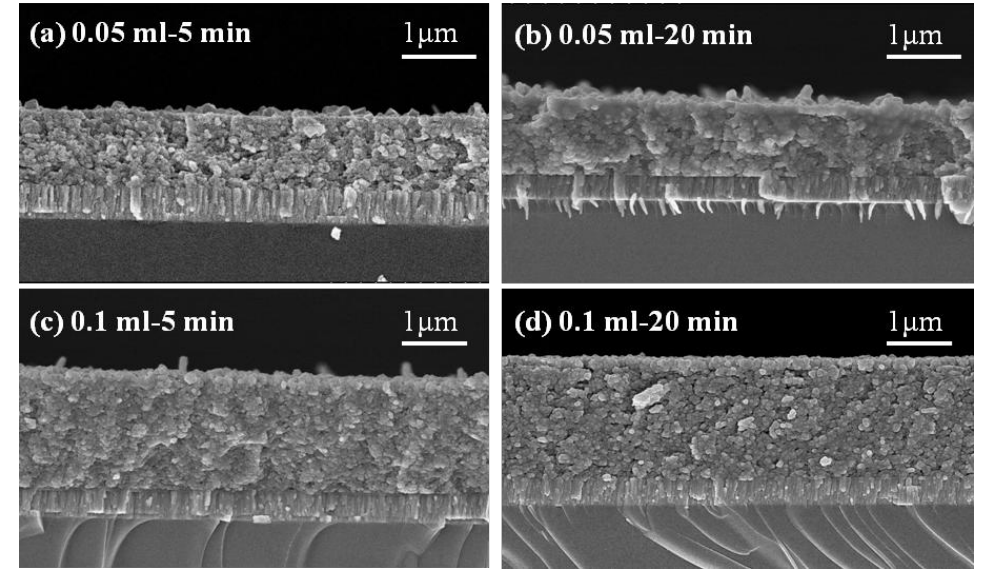
Figure 7. Cross section observations of the CIS absorber layers as a function of annealing time and using solution volume. ( a ) 0.05 mL–5 min; ( b ) 0.05 mL–20 min; ( c ) 0.1 mL–5 min; ( d ) 0.1 mL–20